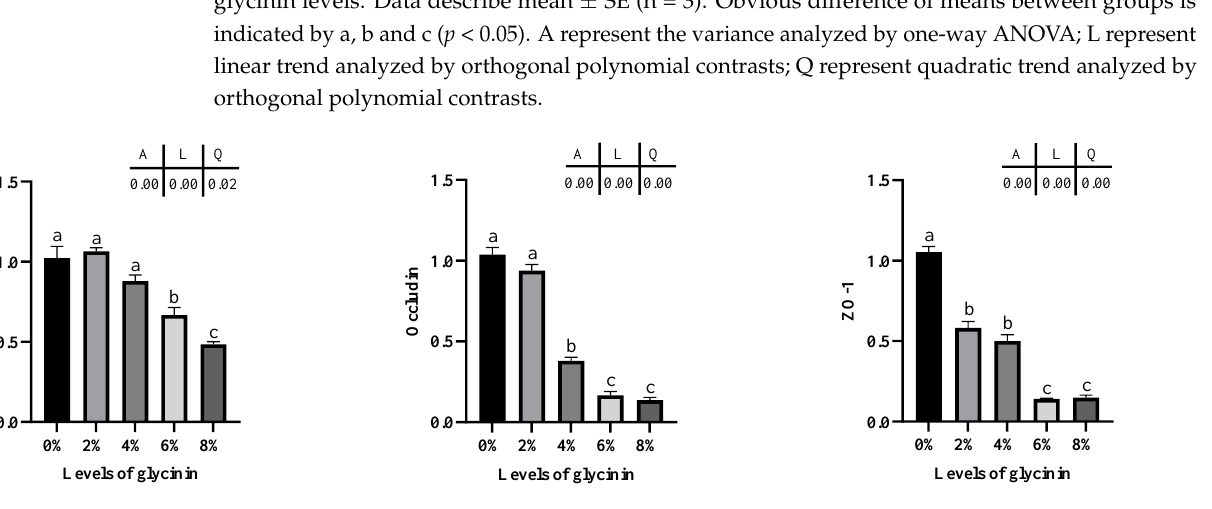
Figure 6. Relative mRNA expression of Claudin-1, Occludin and ZO-1 in posterior intestine of hybrid yellow catfish fed with different glycinin levels. Relative mRNA expression was evaluated by RT-qPCR. Data describe mean ± SE (n = 3). Obvious difference of means between groups is indicated by a, b and c ( p < 0.05). A represent the variance analyzed by one-way ANOVA; L represent linear trend analyzed by orthogonal polynomial contrasts; Q represent quadratic trend analyzed by orthogonal polynomial contrasts.